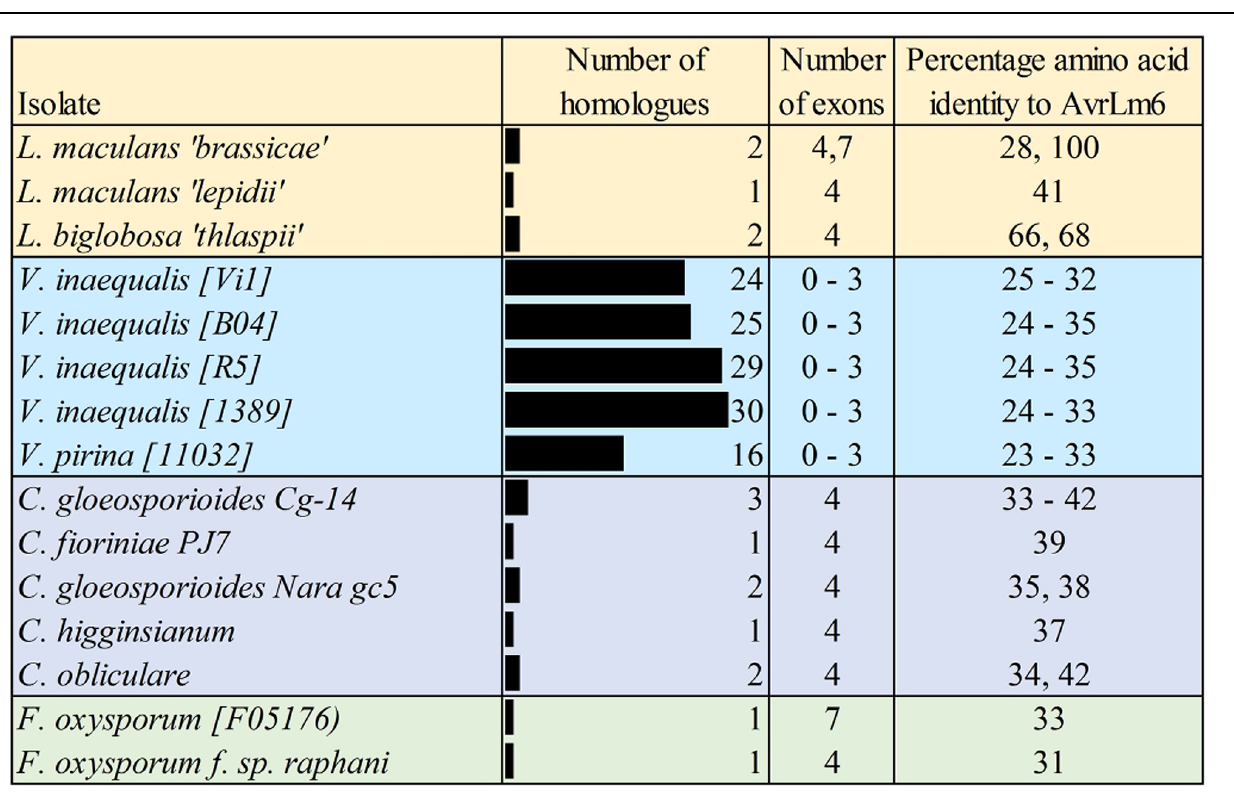
FIGURE 1 | Summary of the AvrLm6 homologs identified in public and private sequence databases. The number of exons predicted for each gene are shown as well as the percentage amino acid identity to the AvrLm6 predicted protein (CAJ90695) from blastp searches. Accession numbers and further details of homologs are detailed in the Supplementary Table